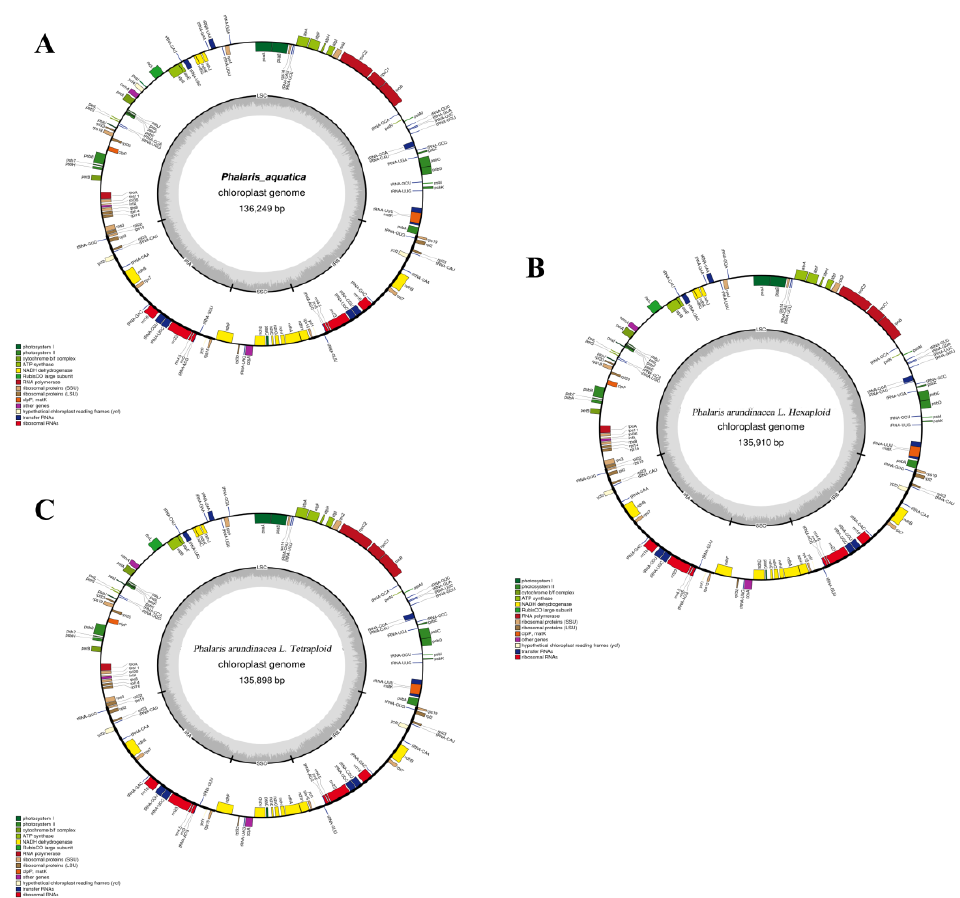
Figure 1. Gene maps of the Phalaris chloroplast genomes. Genes inside and outside of the circle are transcribed in clockwise and counterclockwise directions, respectively. The GC content and adenylate and thymine (AT) content are shown in dark gray and light gray, respectively. ( A ) P. aquatica ; ( B ) hexaploid P. arundinacea ; ( C ) tetraploid P. arundinacea